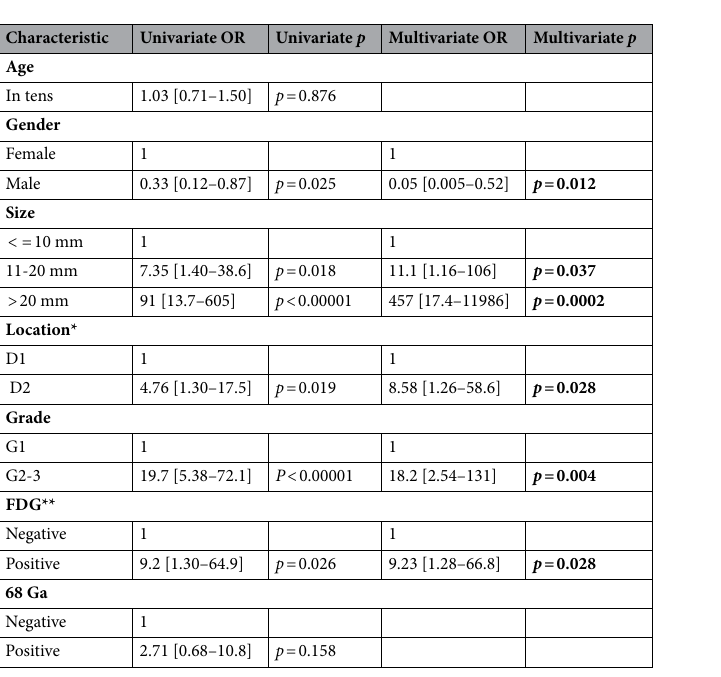
Table 3. Summary of univariate and multi-variate cause logistic regression for all non-functioning dNENs to predict LN metastases. *Location was multi co-linear with FDG and size, so was analysed in a separate multivariate model—please see supplementary tables. **FDG was multi co-linear with grade, location and size, so was analysed in a separate multivariate model—please see supplementary